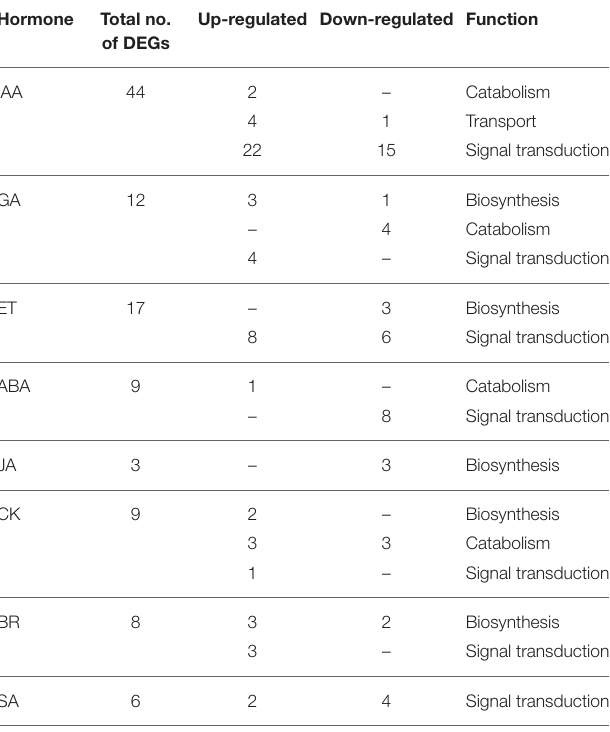
TABLE 4 | Differential expression patterns of plant hormone metabolism and signaling-related genes in comparison of libraries FPAB vs. FPNAB. Hormone Total no. of DEGs